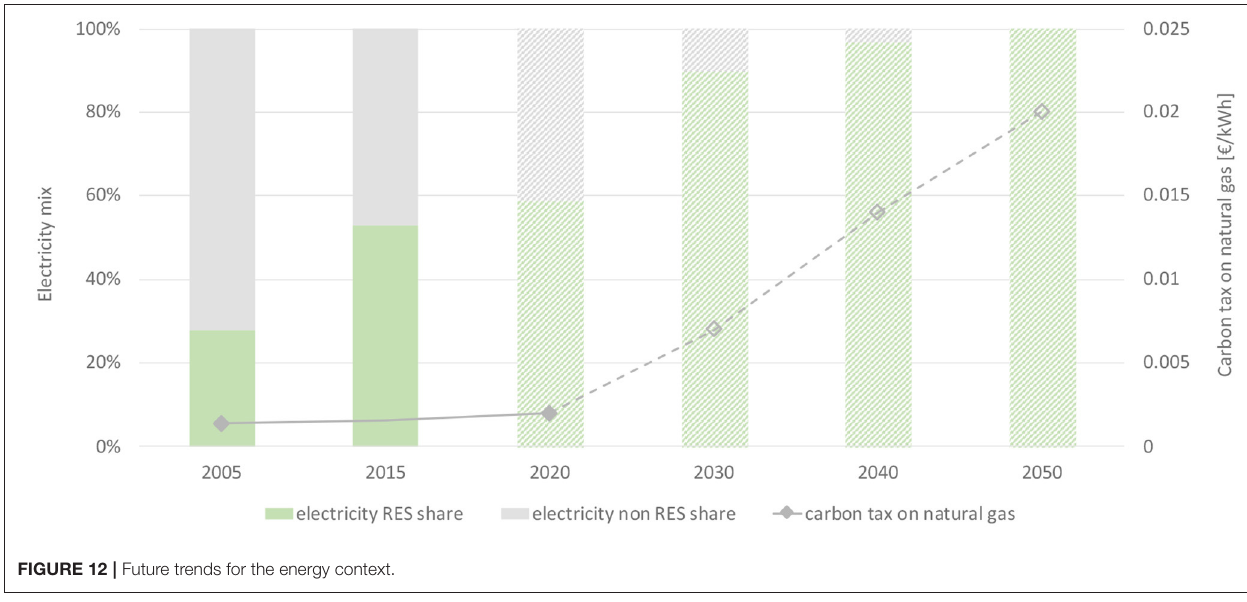
FIGURE 12 | Future trends for the energy context.